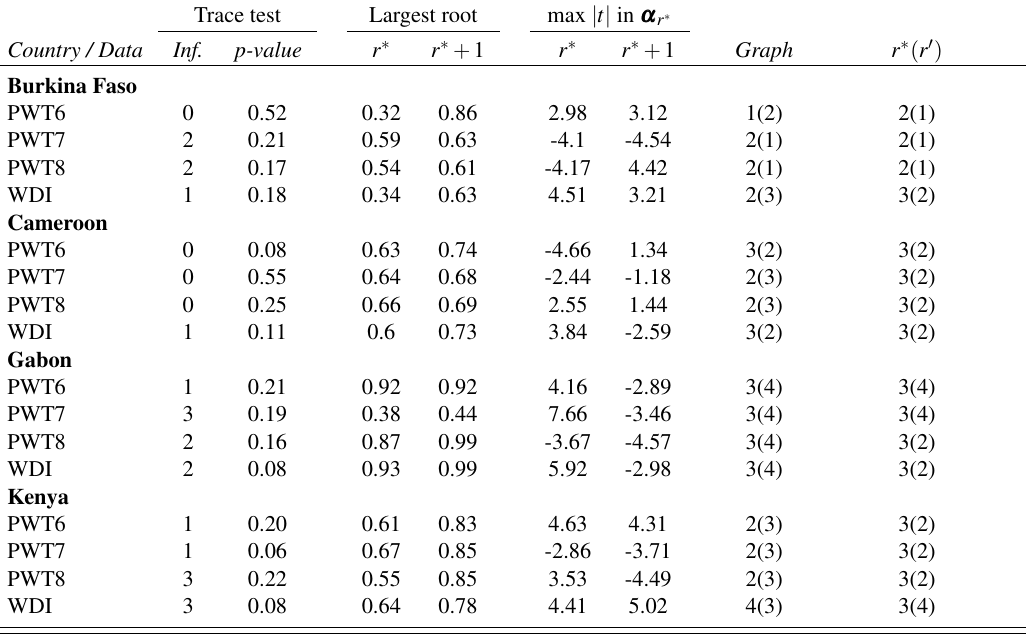
Table 8: Criteria for the choice of